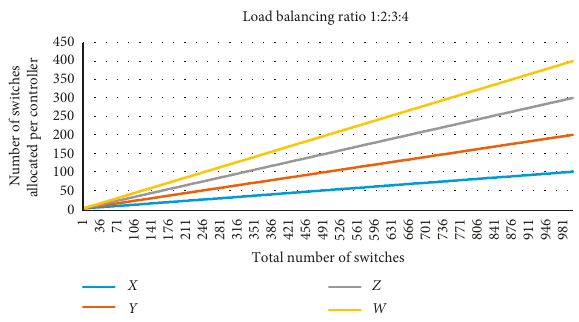
Figure 7: Load balancing for four slave controllers with ratios 1 :2: 3:4. Load balancing ratio 1:3:5:7